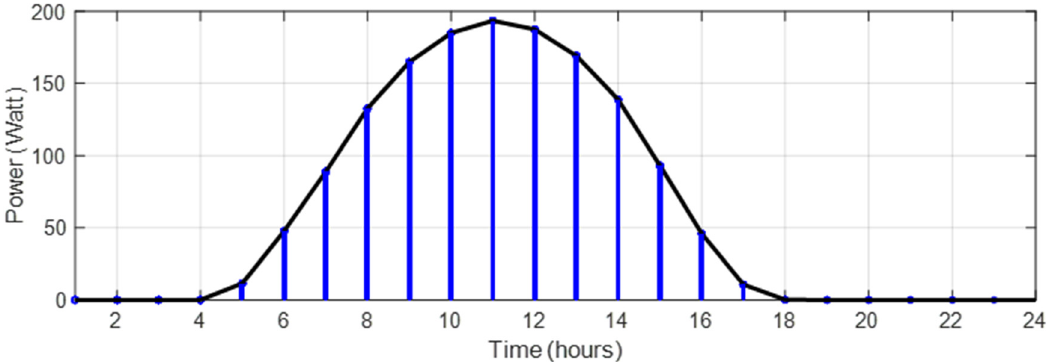
Figure 4. Real single PV module output